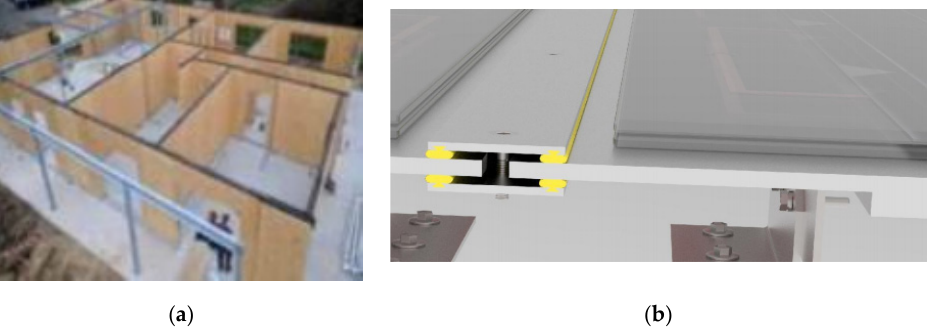
Figure 4. ( a ) Standard panel assembly; ( b ) cross-section of the vertical watertight functionality (primary weather protection) for